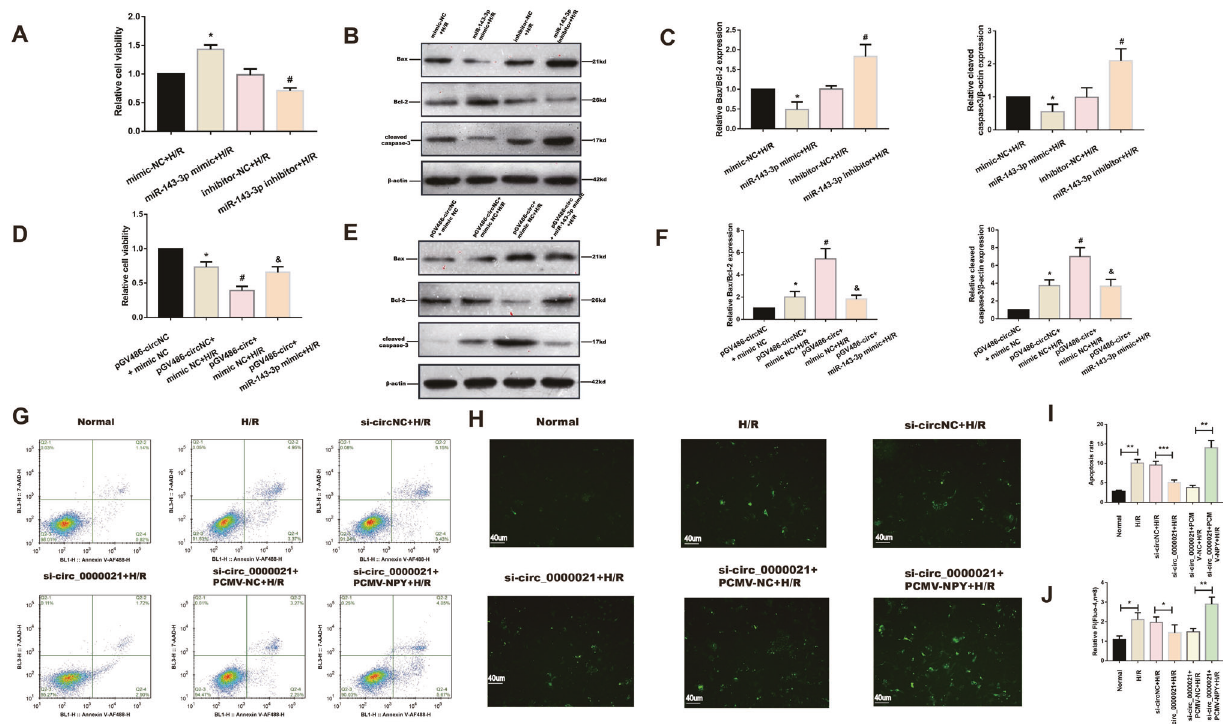
Fig. 4 MiR-143-3p is responsible for mmu_circ_0000021-mediated calcium in fl ux in cardiomyocytes and reduces H/R-induced cardiomyocyte apoptosis by via NPY. A , D The CCK-8 assay was used to determine relative cell viability. B , E Expression of apoptosis- associated proteins in response to injury or death, * P < 0.05 compared with the mimic-NC group + H/R, # P < 0.05 compared with the inhibitor- NC + H/R group; n = 3/group. C , F Expression of circRNA and related apoptotic proteins determined by Western blot analysis, * P < 0.05 compared with the pGV486-circNC + mimic-NC group, # P < 0.05 compared with the pGV486-circNC + mimic-NC + H/R group, & P < 0.05 compared with the pGV486-circ + mimic-NC + H/R group, n = 3/group. G , I Flow cytometry and quantitative analysis of the degree